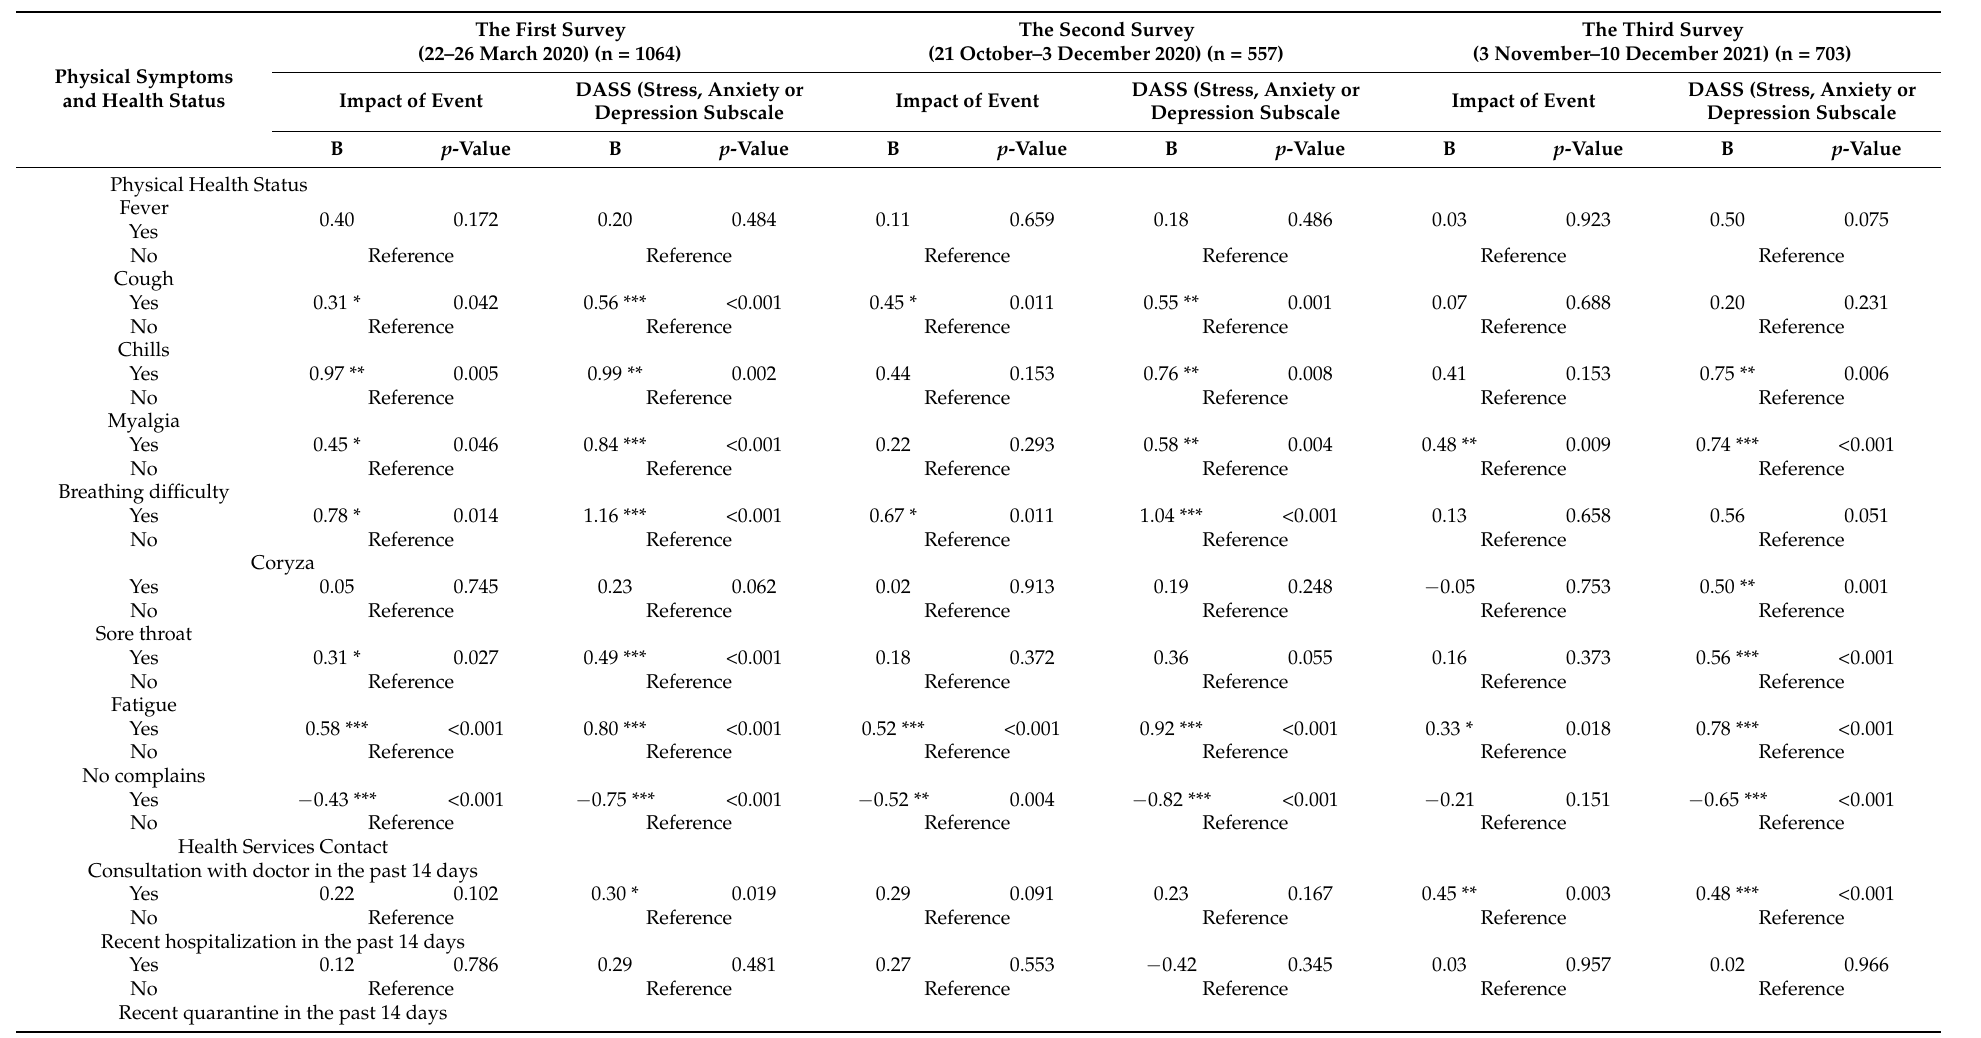
Table 2. Association between physical health status and the psychological impact as well as adverse mental health status during the first, second and third surveys (n = 2324)